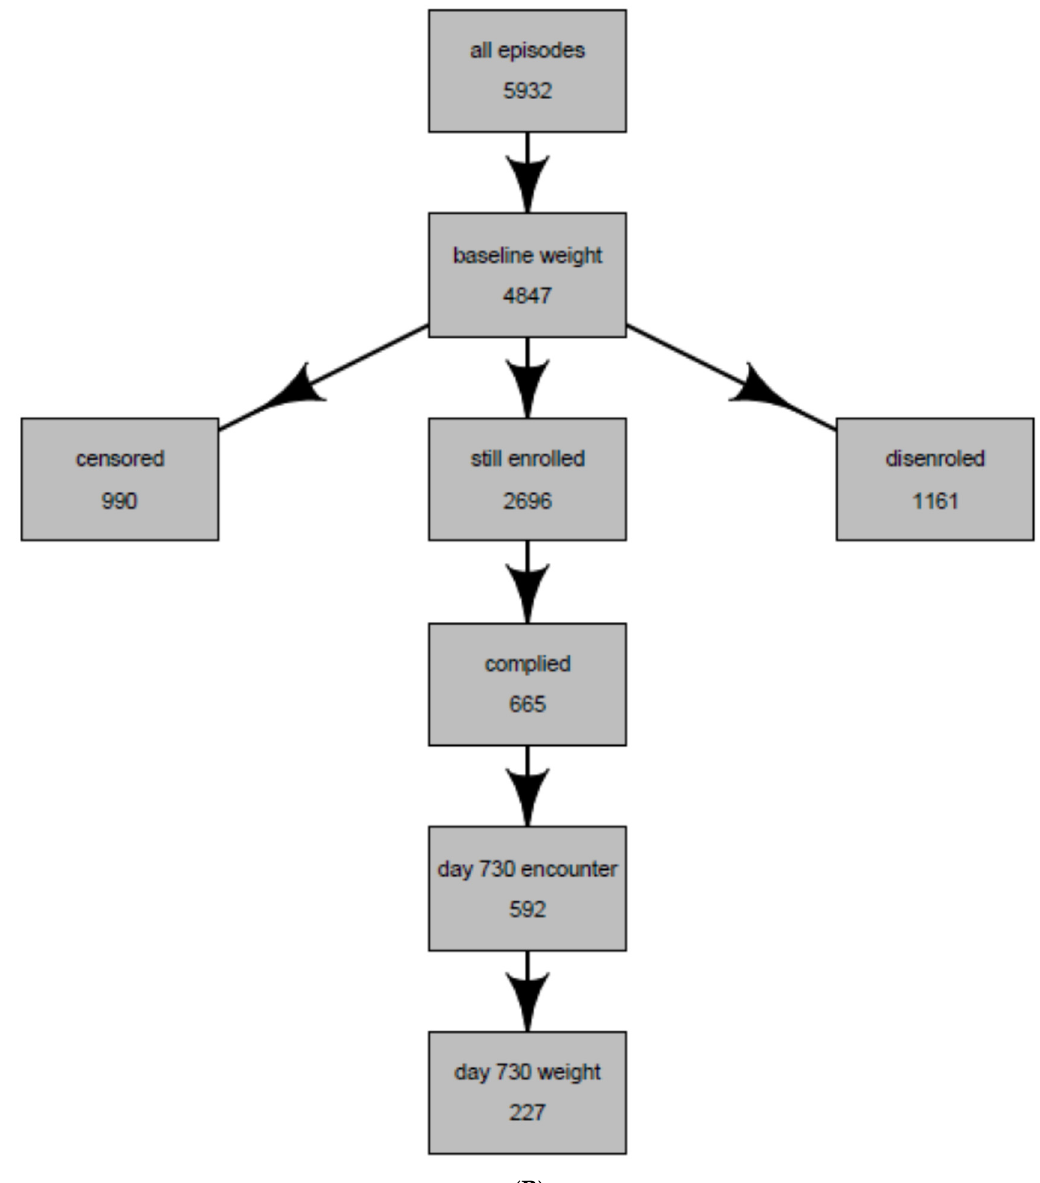
Figure 1. ( A ) Flow of the intent ‐ to ‐ treat population of antidepressant users; and ( B ) Flow of the per ‐ protocol population of antidepressant users. Censored = patients were censored if they were using drugs or underwent procedures that have strong effect on weight change (see methods); Still enrolled = still enrolled at Group Health at day 730 (two years); Day 730 encounter = patient had an ambulatory encounter in the Integrated Group Practice (IGP); Day 730 weight = patient had a weight recorded at that encounter. Table 1. Characteristics of the entire population of antidepressant users and antidepressant users with observable weight data at two years *